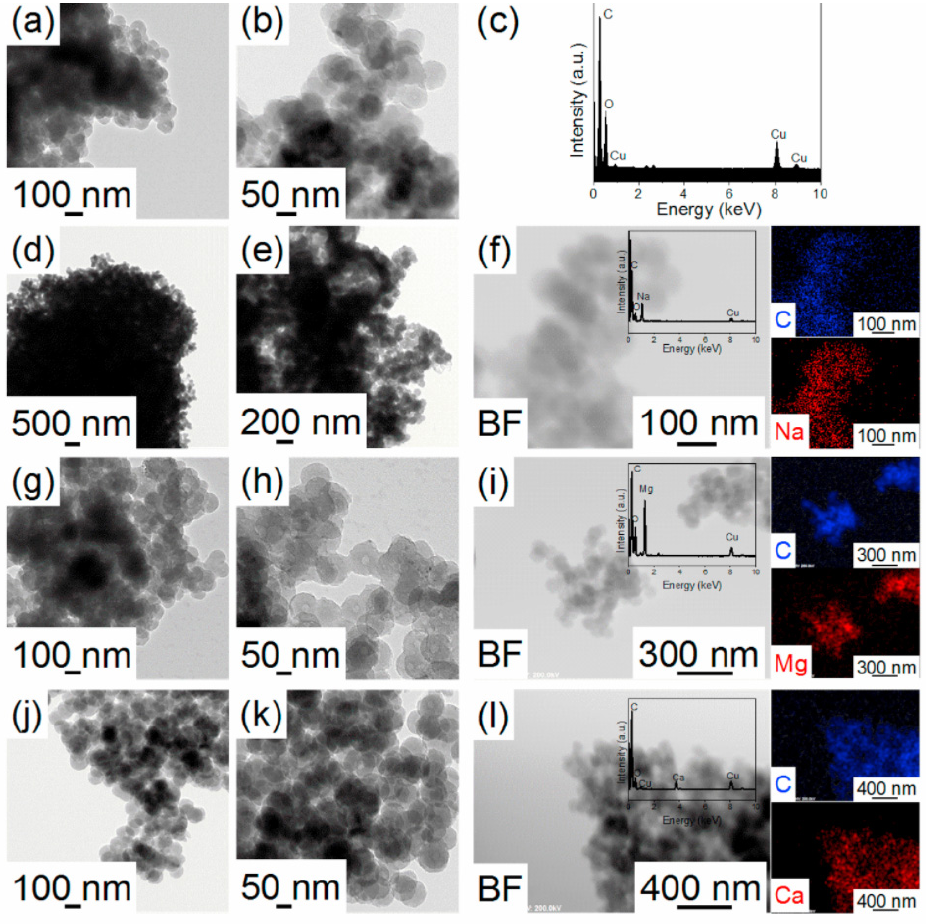
Figure 13. Typical TEM images, elemental mapping and EDS analysis of ( a – c ) LiBH 4 -HCNs, ( d – f ) NaBH 4 -HCNs, ( g – i ) Mg(BH 4 ) 2 -HCNs and ( j – l ) Ca(BH 4 ) 2 -HCNs via the melt infiltration method. Reprinted with permission from [136]. Copyright (2019), Elsevier.